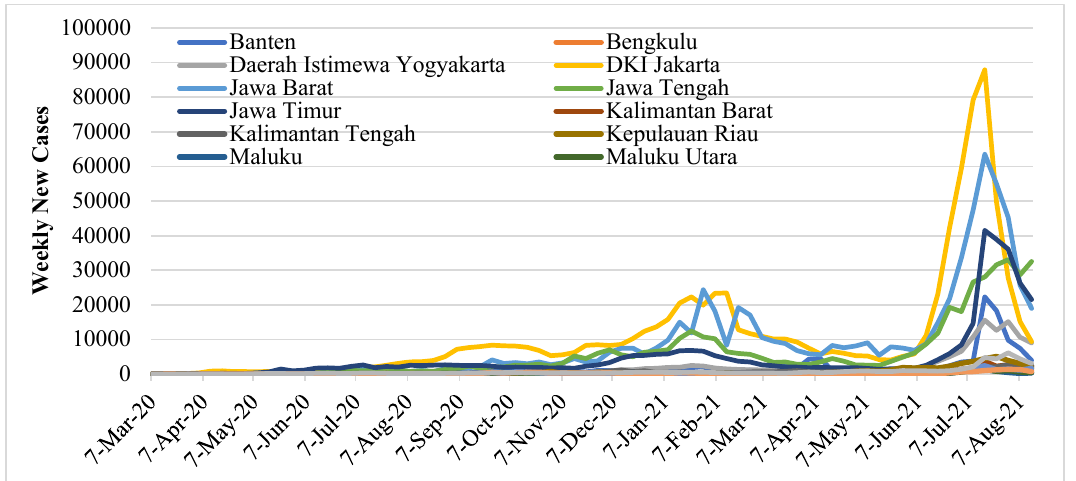
Fig. 7. Result of weekly new cases of COVID-19 in Cluster 3